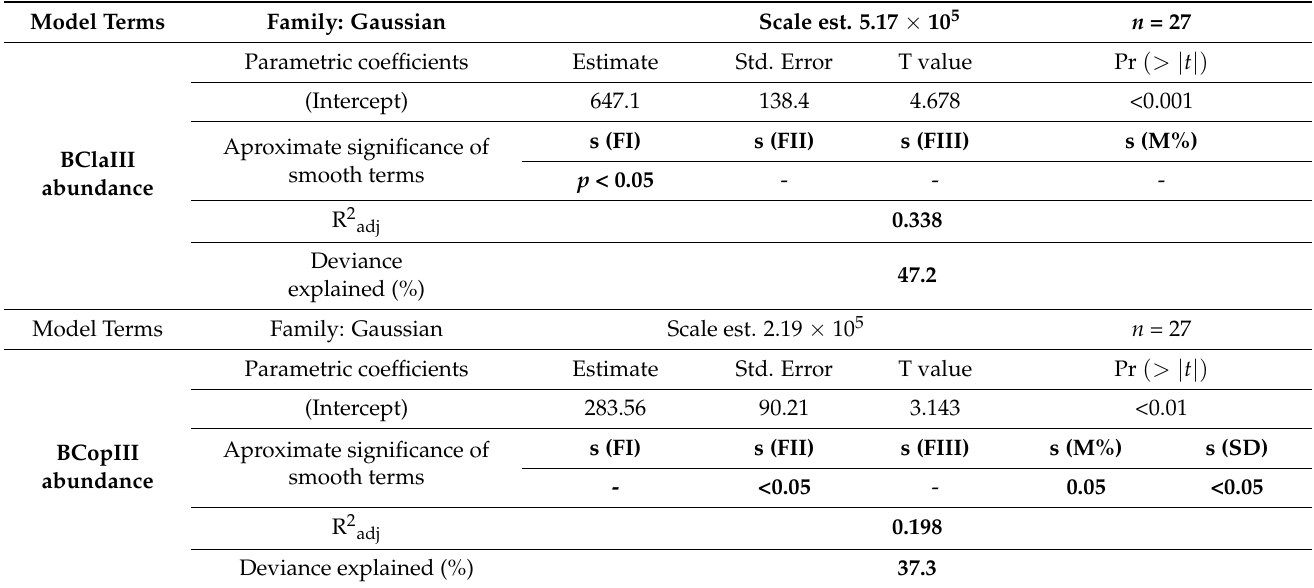
Table 3. Parameters of GAMs describing the factors involved as drivers of changes in BClaIII and BCopIII during the experiment. Significant p values are given in the